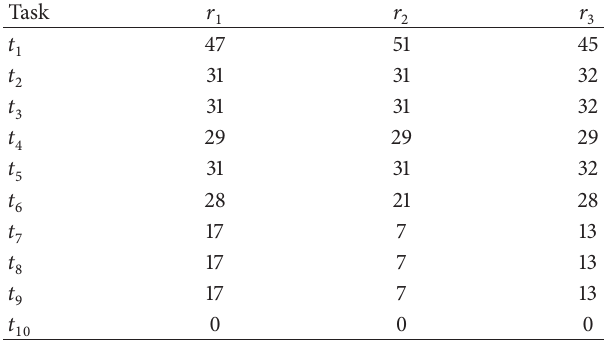
Table 3: Optimistic cost table for the DAG of Figure